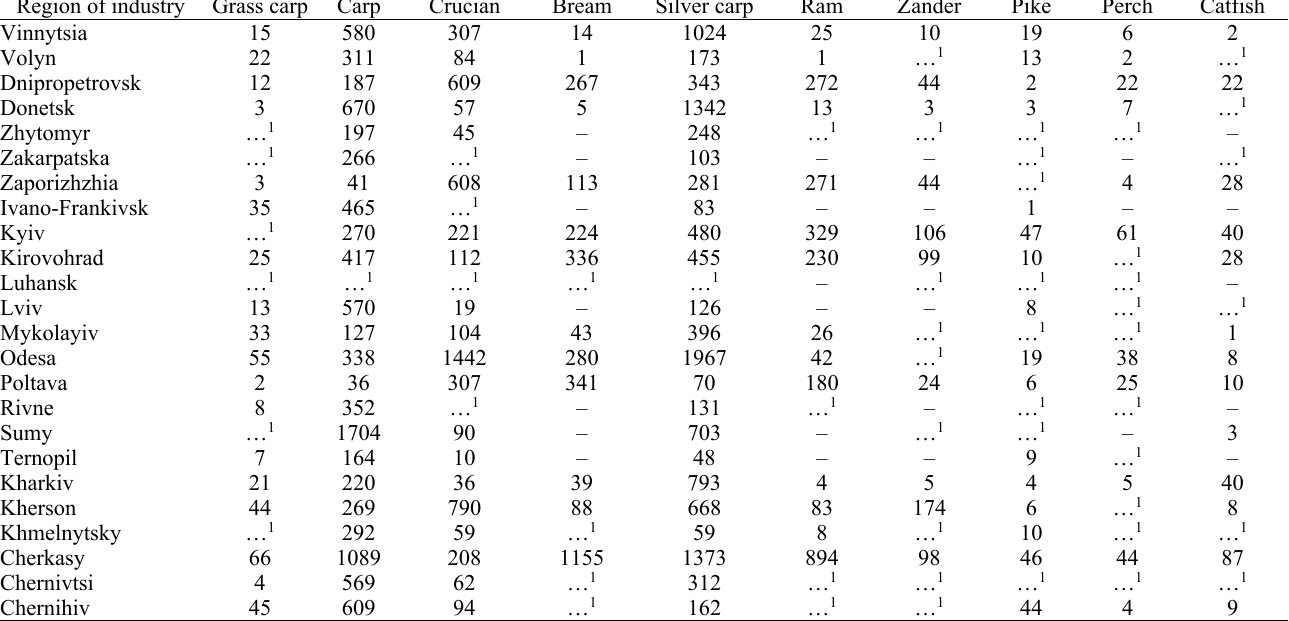
The structure of fishing by region in the inland waters of Ukraine in 2015, t (according to the State Statistics Service of Ukraine) (Derzhavna sluzhba statistiki Ukrayini) Region of